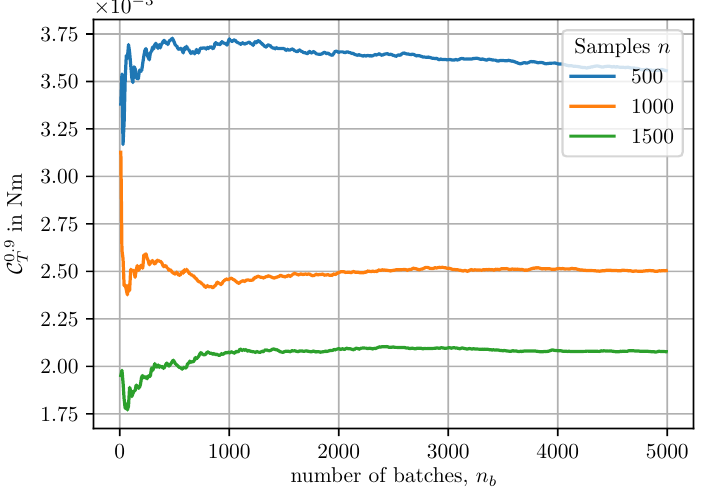
0.9 over number of batches for different numbers of T C